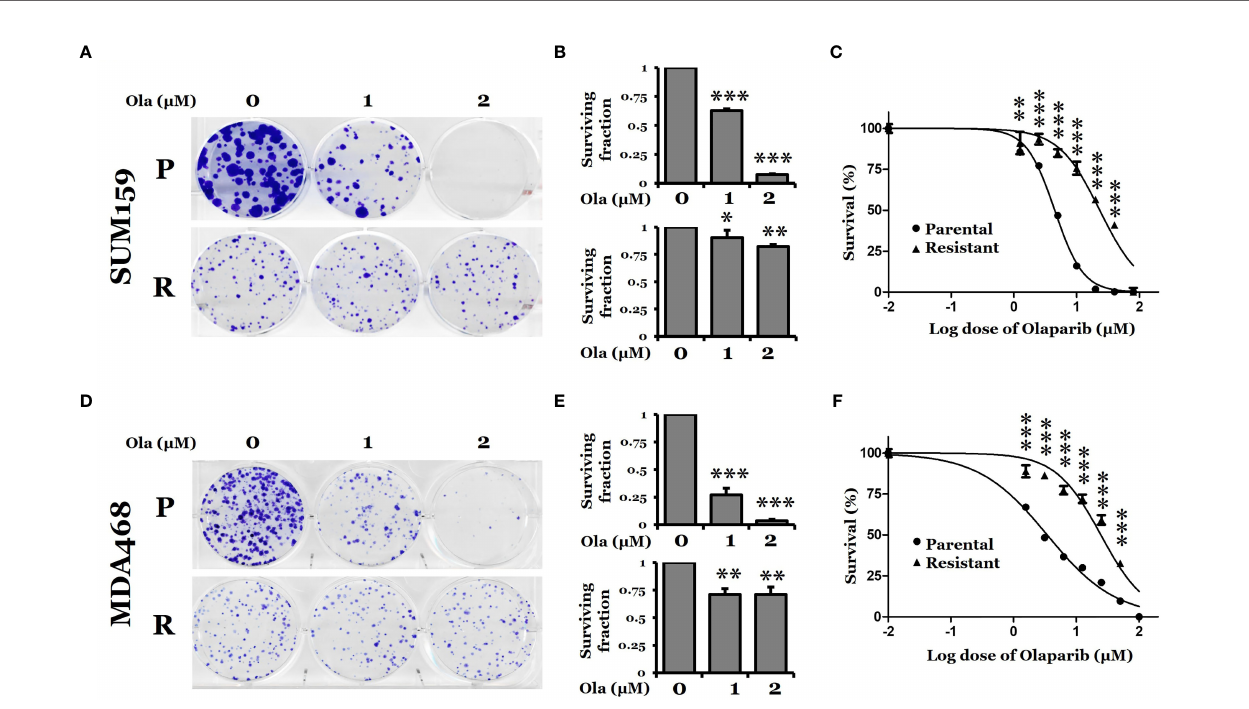
FIGURE 1 | Clonogenic survival of PARP inhibitor olaparib-sensitive and -resistant TNBC cells. (A, D) Colony formation assay for SUM159 and MDA468 parental (P) and olaparib resistant (R) cells. Cells were treated with either DMSO or olaparib for 72 hrs and allowed to grow in a drug-free medium for 10 days. All treatments were carried out in triplicate, and the images are representative of the response to olaparib. (B, E) Surviving fraction calculated from A and D, respectively. (C, F) Dose-response curve for parental and olaparib resistant SUM159 and MDA468 cells. Resistant cells were obtained by selection with increasing concentrations of olaparib in the culture media for six months. After the development of resistance, SUM159-R and MDA468-R cells were maintained in media containing 25 µM and 15 µM olaparib, respectively. Cell viability was measured using MTT assay after treating with varying concentrations of olaparib for 72 hrs. After adding MTT to the media, cells were incubated at 37 ˚ C for 2 hrs. The formazan crystals were dissolved in DMSO and then read by spectrophotometer at 570 nm. Data represented as mean ± standard deviation (SD). All experiments were done in triplicates. Ola, olaparib. Student ’ s t-test: * p < 0.05; ** P < 0.01 and *** P <